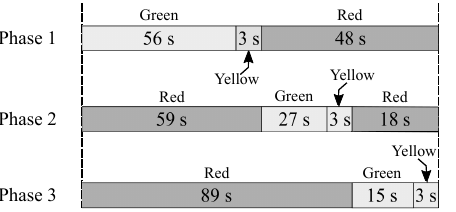
Figure 6. Configuration of the current pre-timed control at the case study.